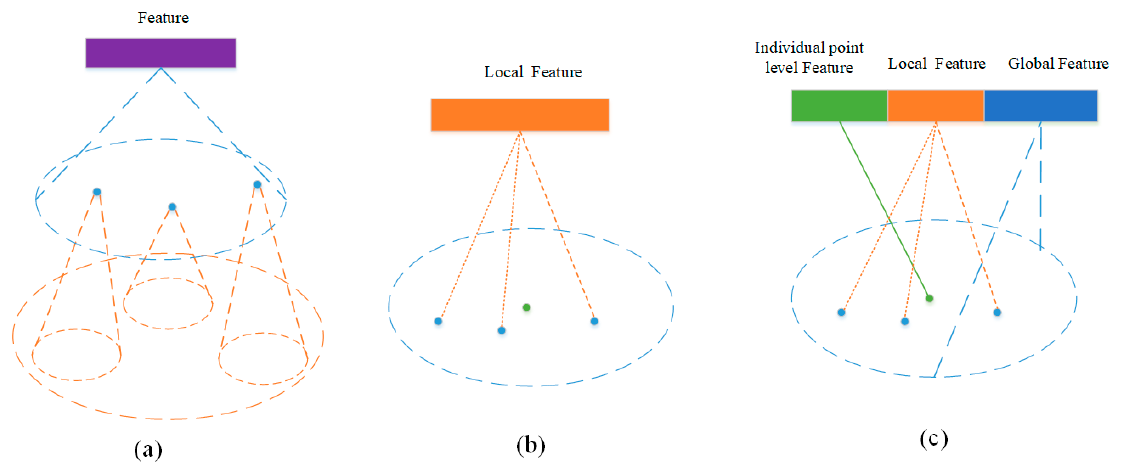
Figure 2. Feature learning with multi-resolution grouping (MRG) method. ( a ) Sketch of MRG, with each cone representing feature learning. ( b ) Feature learning in the original PointNet++. ( c ) Feature learning with proposed